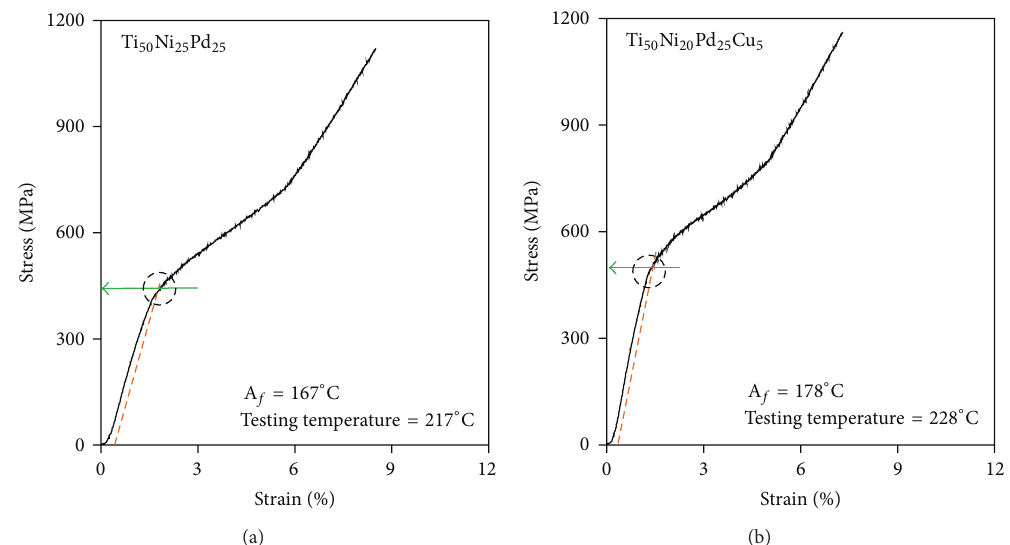
Figure 3: Tensile stress-strain curves tested in the austenite condition, 50 ∘ C above A 𝑓 of (a) Ti 50 Ni 25 Pd 25 and (b) Ti 50 Ni 20 Pd 25 Cu 5 alloys.